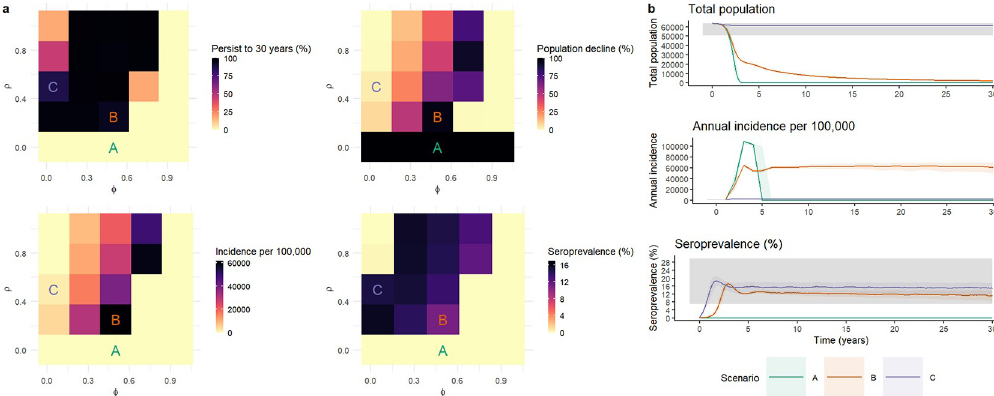
Fig 2. Results from non-spatial model of effects of non-lethal exposure ( ϕ ) and acquired immunity ( ρ ) on probability of rabies persistence, median percentage population decline, median annual incidence per 100,000 and median predicted percentage seroprevalence. Plot a presents the median values for the full range of parameter combinations. Plot b shows a subset of parameter combinations (Scenarios A, B and C) indicated by labels on plot a with median values and interquartile ranges over the full 30 years for total population size, annual incidence per 100,000 dogs and seroprevalence (%). Grey bands indicate the range of values considered plausible based on empirical estimates, as shown in Table